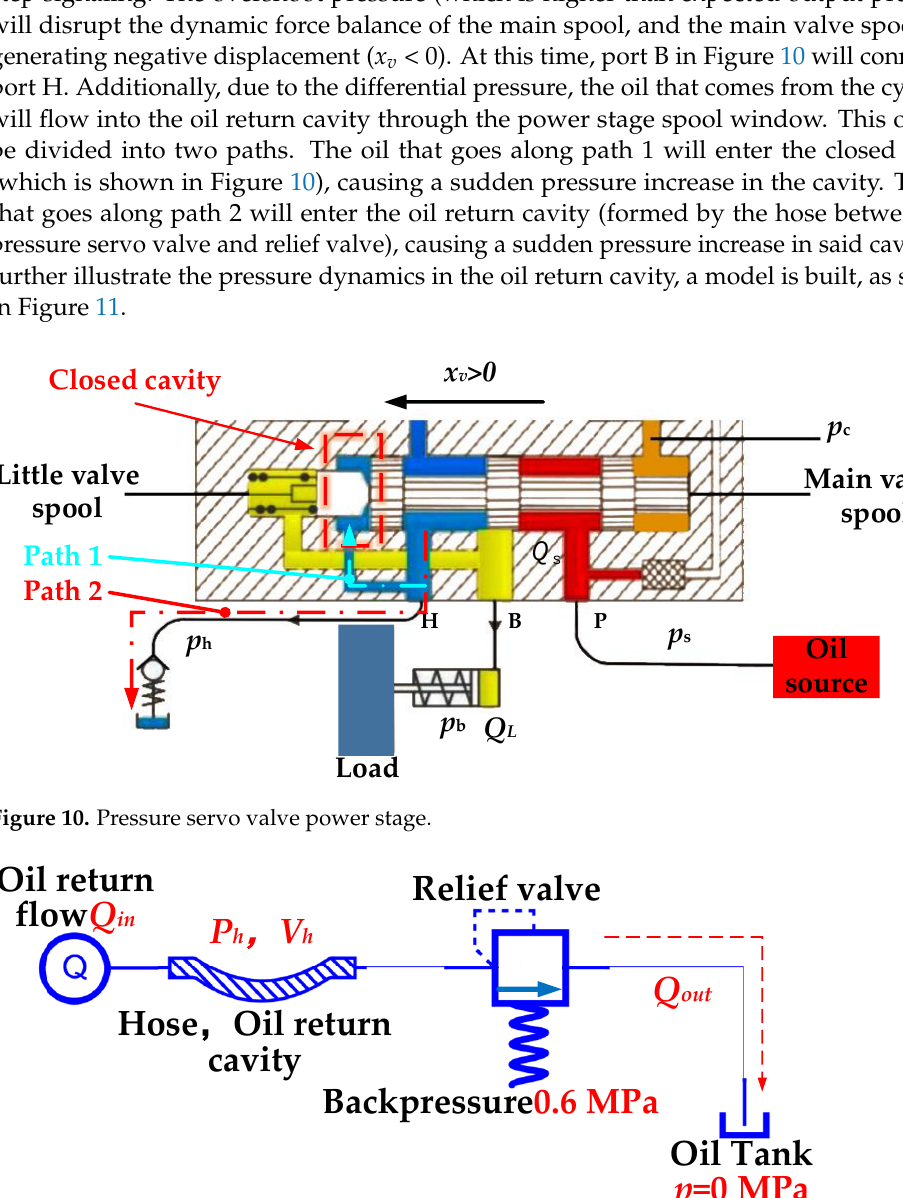
Figure 11. Model of the oil return cavity.